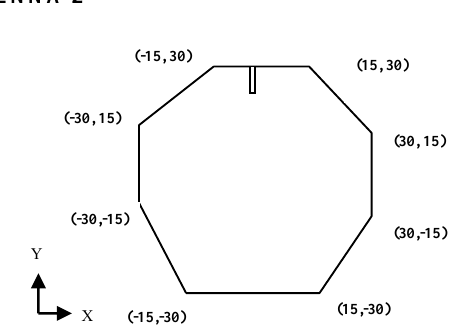
Fig.1.8. S 11 Response of the Antenna